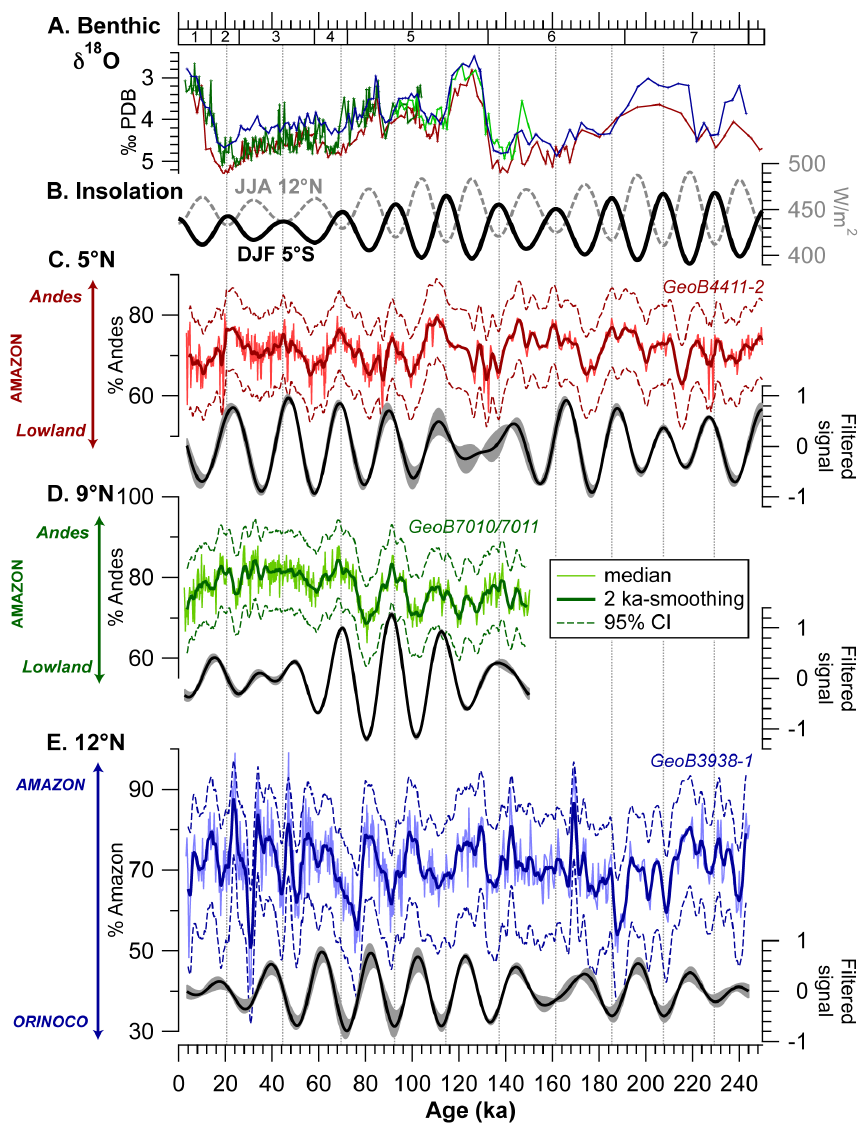
Fig. 6. (A) Benthic δ 18 O records from cores GeoB4411-2 (red), GeoB7010/7011 (green) and GeoB3938-1 (blue). (B) December-January- February (DJF, black line) and June-July-August (JJA, dashed grey line) insolation curves (Laskar et al., 2004). (C) – (E) Percentages of Andean material (%-Andes in C and D ) and Amazon material (%-Amazon 1 in E ) within the terrigenous fraction (left y axes). Median values (light line=all data; thick line= 2ka-smoothed data after resampling every 0.25ka) and non-parametric 95% confidence intervals (CI, 2.5th and 97.5th percentiles, dashed line=2 ka-smoothed data) are presented. Records bandpass filtered in the 0.035–0.055ka − 1 frequency interval (periodicities of ∼ 18–28ka) are shown on the right y axes. The black line and grey envelope represent the median and 95% confidence interval (2.5th and 97.5th percentiles) of all filtered records, respectively. Grey vertical dotted lines highlight DJF (JJA) insolation maxima (minima). Marine isotope stages are indicated at the top of (A)